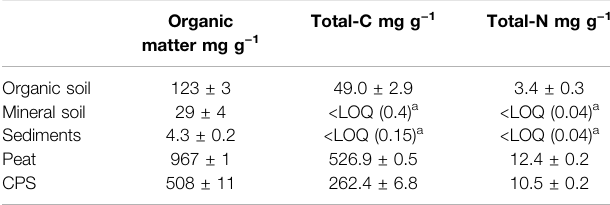
TABLE 1 | Organic matter, total-C and Total-N contents of soils, sediments, and additives. Organic matter mg g −